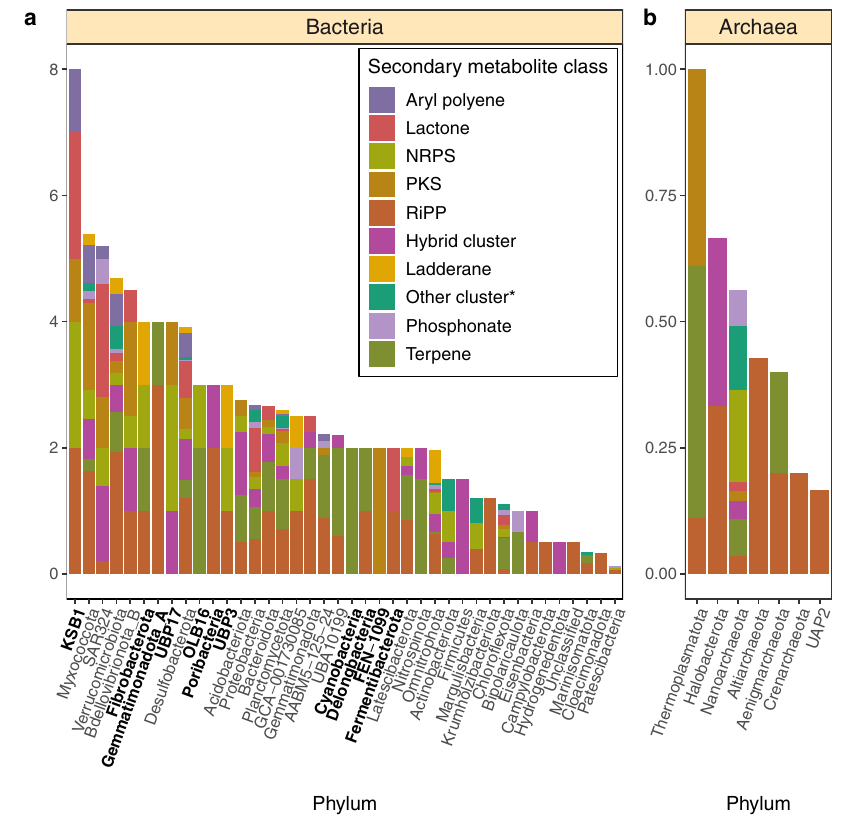
Fig. 1 | Normalized biosynthetic gene cluster count per phylum. a Normalized bacterial biosynthetic gene cluster count by phylum. b Normalized archaeal bio- synthetic gene cluster count by phylum. Bold labels denote underrepresented